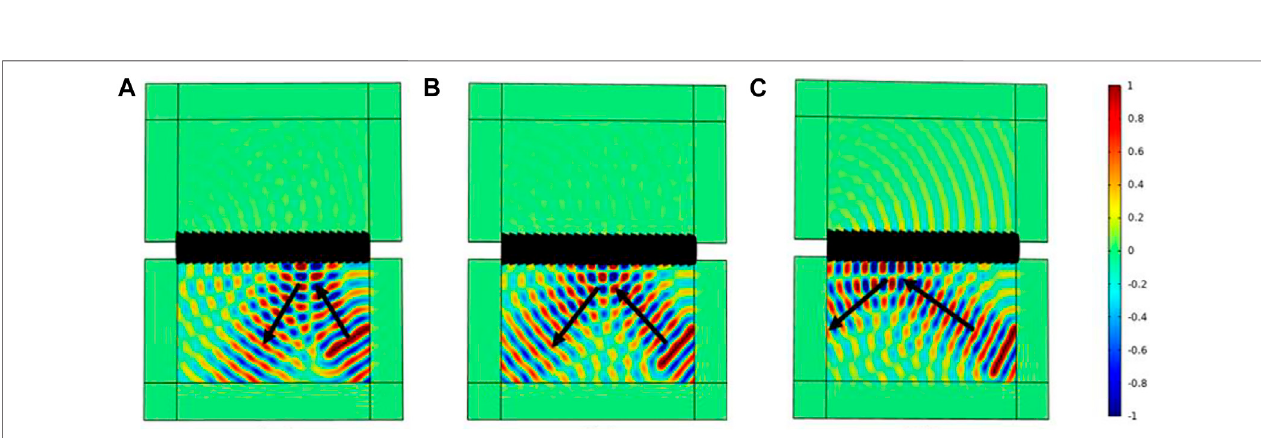
FIGURE 14 | When the number of unit cells is m = 8, the wave fi eld of the incident wave incident at different angles: (A) 30 ° ; (B) 45 ° ; (C) 60 ° .